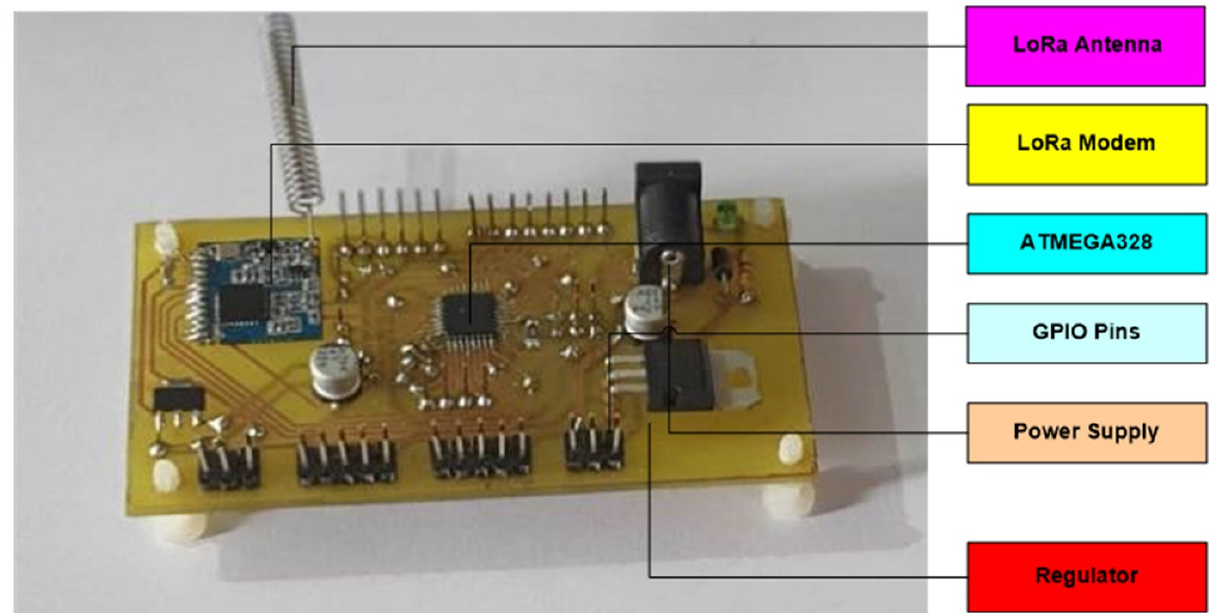
Agronomy 2021 , 11 , x FOR PEER REVIEW Figure 3. LoRa end node custom design for agriculture farm. Figure 3. LoRa end node custom design for agriculture farm.